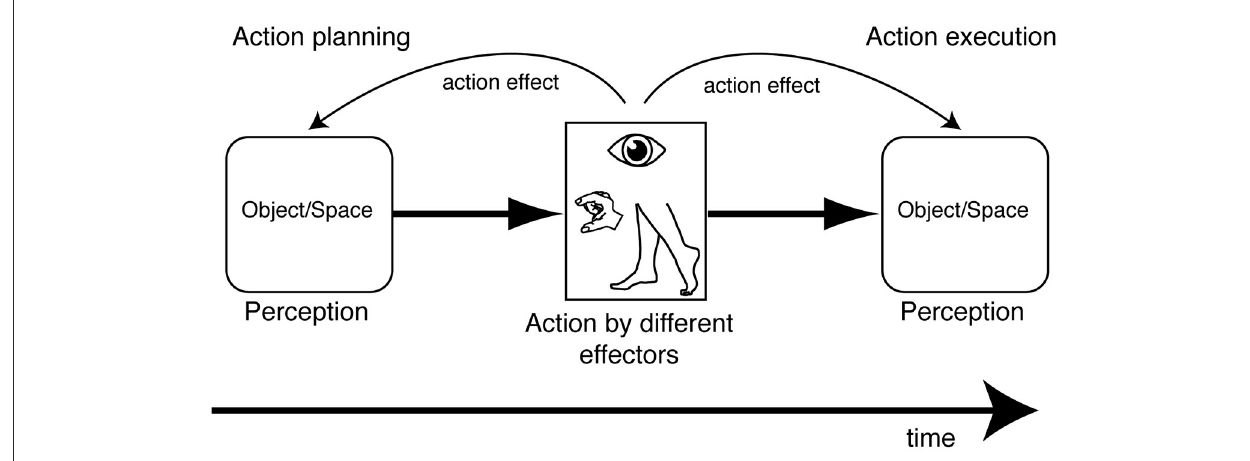
FIGURE8 Summary of object/space perception modulation by action planning and action execution evoked by movement of different